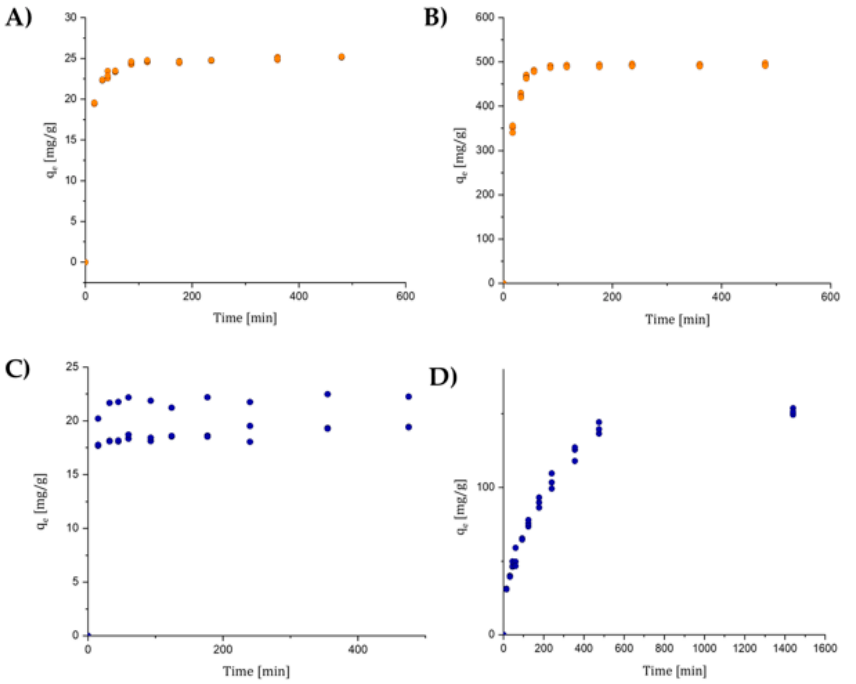
Figure 7. ( A ) OSS kinetic behavior. Initial concentration of 20 mg/L. ( B ) OSS kinetic behavior. Initial concentration of 800 mg/L. ( C ) NBB kinetic behavior. Initial concentration of 20 mg/L. ( D ) NBB kinetic behavior. Initial concentration of 250 mg/L.